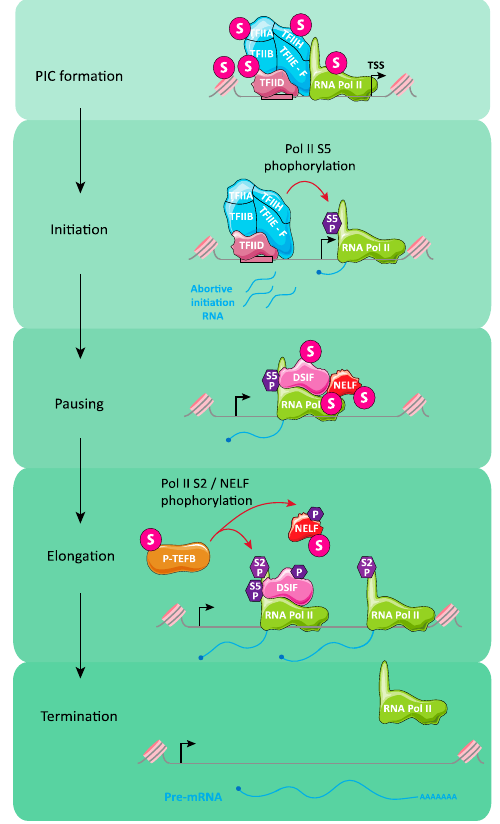
Figure 5. SUMO in transcription initiation and elongation by Pol II. PIC formation: the pre-initiation complex forms just upstream of the transcriptional start site in a nucleosome-free domain, provided that chromatin is competent for transcription due to the presence of transcription factors bound to their TFBSs, appropriate chromatin access and modifications, etc. (not represented). The general transcription factor TFIID, which binds to DNA, is crucial in this process, as in permits the recruitment of other GTFs as well as Pol II. Pausing of Pol II downstream of the TSS is permitted by the NELF and DSIF multisubunit factors. Release of Pol II on the gene is then permitted by the P-TEFb dimeric factor. Termination of transcription occurs downstream the polyadenylation site. Various subunits of GTFs, Pol II complex, NELF, DSIF can undergo SUMOylation, which alters their activity and, thereby, transcriptional activity (see Text for details on SUMO actions). To which extent and how group SUMOylation is involved in the regulation of transcription initiation and elongation, possibly in a phase separation-dependent manner, is not known. The implication of SUMO in transcriptional termination has not been studied